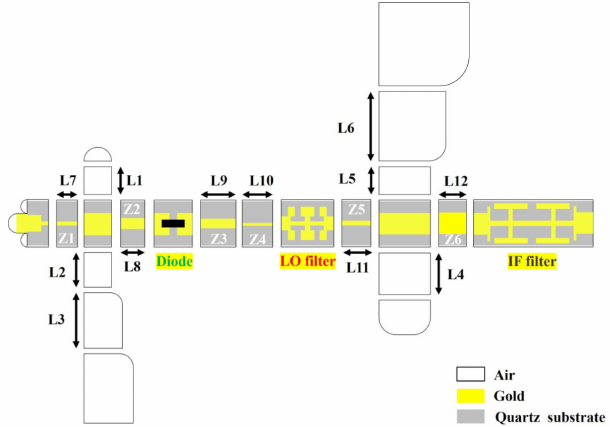
Figure 6. The passive model of the 0.34 THz mixer combining two-stage reduced matching technology with an improved active circuit model.